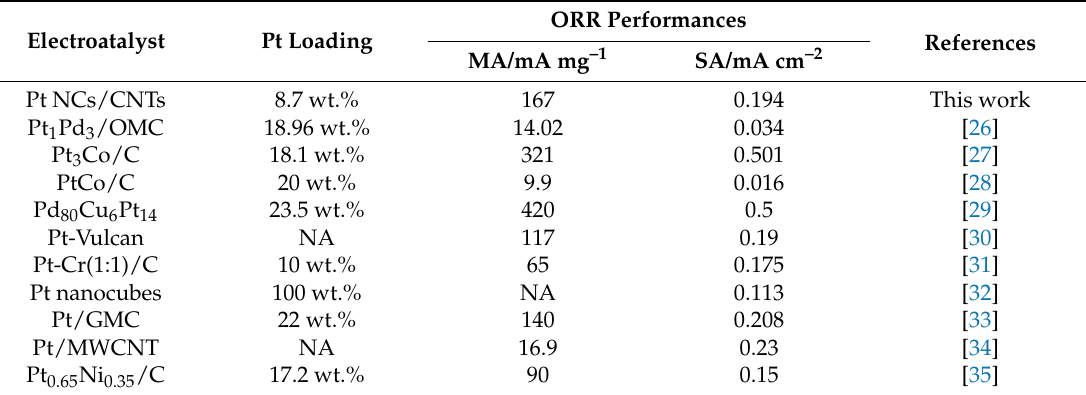
Table 1. Comparison of ORR performances for the present Pt NCs/CNTs-10% and the reported Pt-based catalysts in acid solution at 0.9 V. (NA: not available).